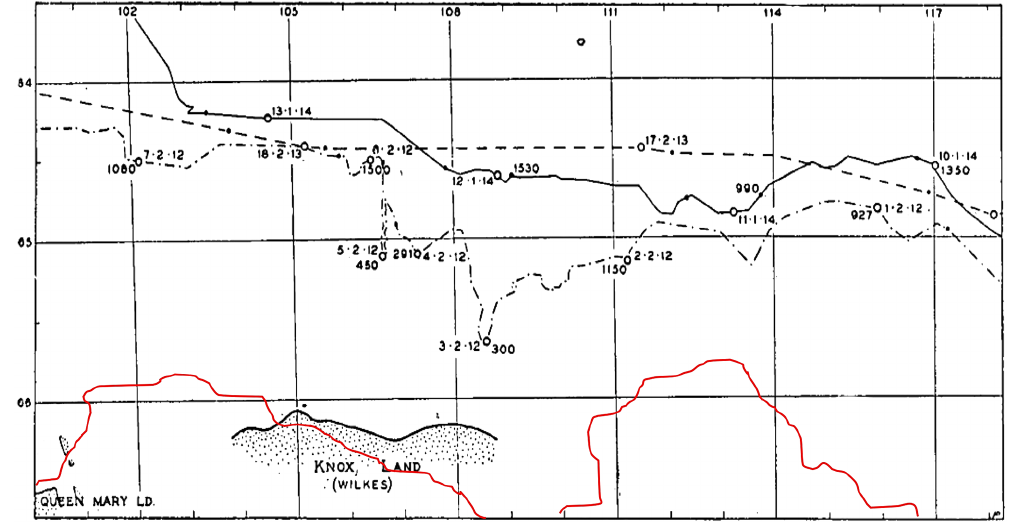
Figure 4. Tracks of the Australasian Antarctic Expedition ship Aurora between Adelie Land and Queen Mary Land during the years of the expedition (1911 to 1914) and observations of the Antarctic coastline. The correct location of the Antarctic coastline has been added in red. Image modified from the expedition report under Commonwealth Copyright